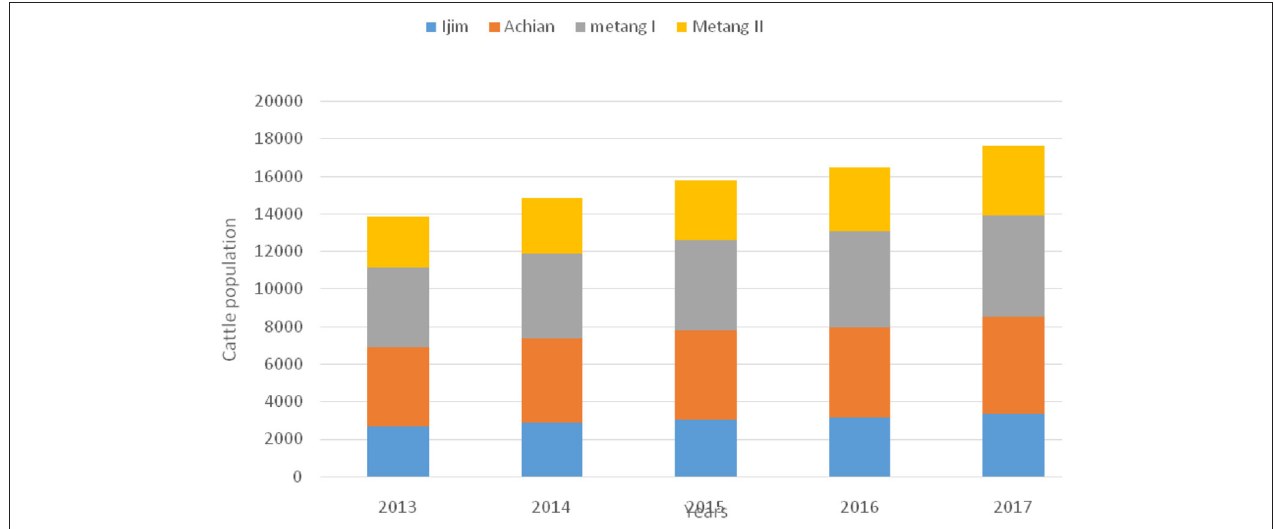
FIGURE 4 | Evolution in cattle population in the main grazing zones. Source: Generated from Field Data